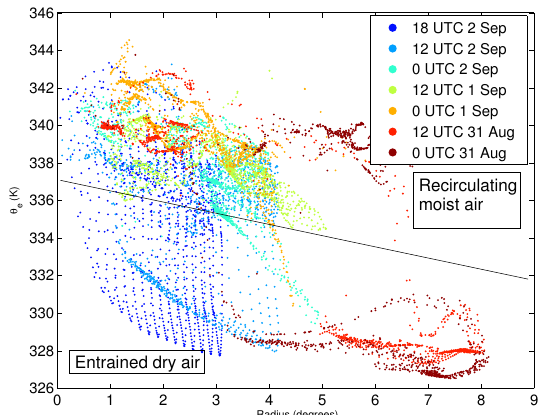
Figure 9. θ e and radial distance from the center of Gaston’s pouch at the 500hPa level. The colors range from brown to blue, with PGI38L brown denoting the earliest time of 00:00UTC 31 August and blue denoting the latest time of 18:00UTC 2